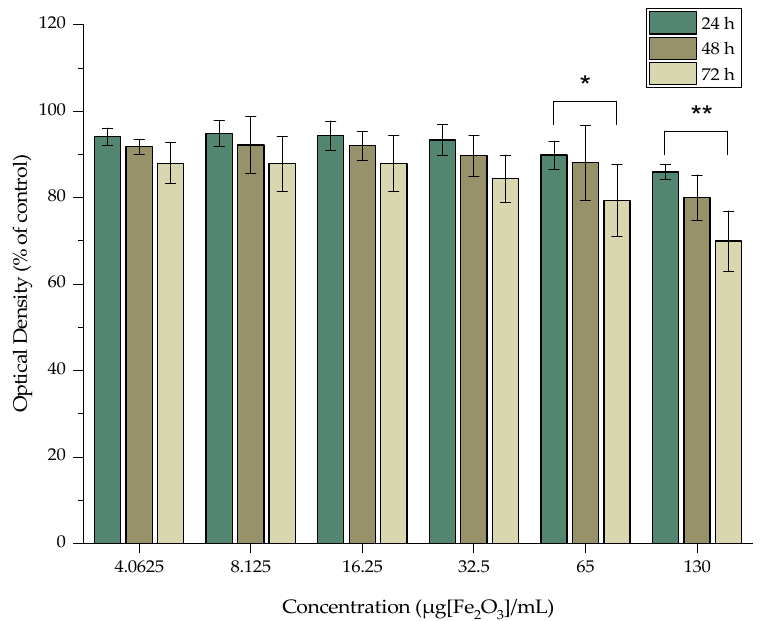
Figure 10. MTT assay of MAPEG against the 4T1 cell line after 24, 48 and 72 h. Mean values ( n = 3) and the SD (bars) are shown (x axis not in scale).